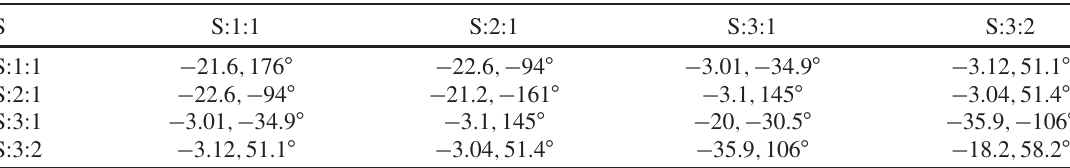
TABLE V. The scattering matrix of the final polarizer with ellipse corrector. S